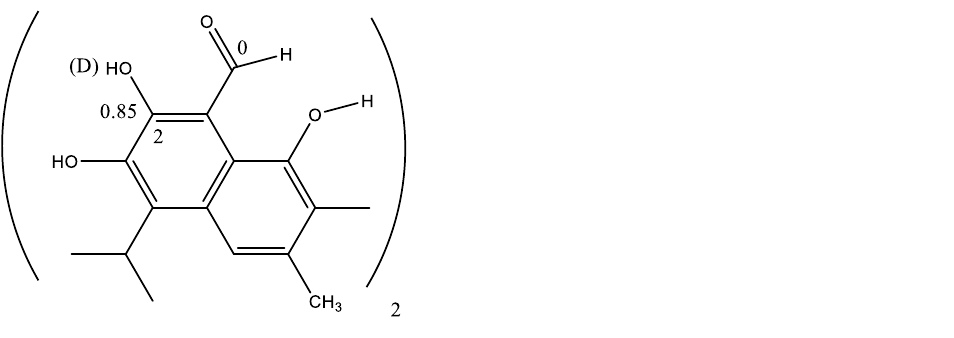
Figure 21. Gossypol. Selected deuterium isotope effect on 13 C chemical shifts in ppm. Data from Ref. [87].